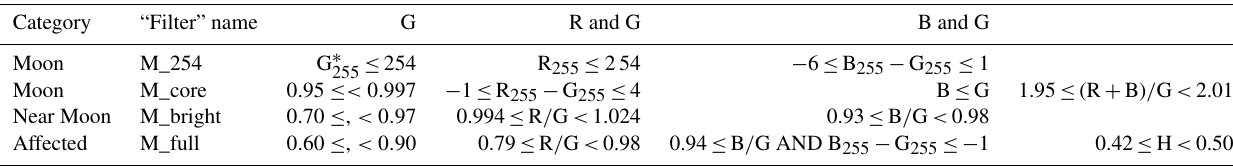
Table 3. Criteria of a pixel for the Moon and its surrounding (the same format as Table